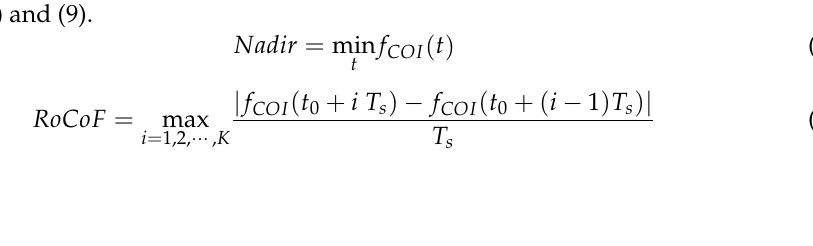
Figure 11. Frequency of the synchronous generators (IBR penetration rate was 80%) ( a ) #1-80, ( b ) #3-GFL-80, ( c ) #3-GFL-V-80, and ( d ) #3-GFM-80.